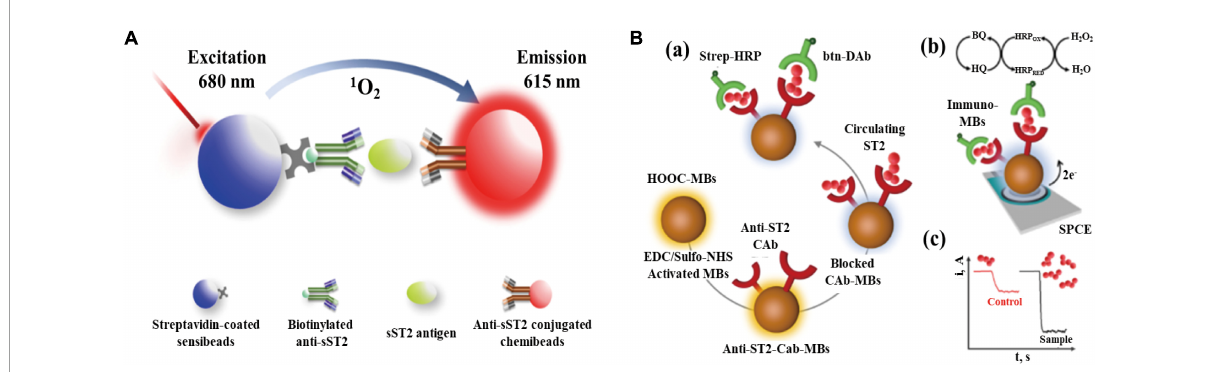
FIGURE3 (A) Schematic representation of AlphaLISA for measuring soluble growth stimulation expressed gene 2 (sST2) through double-antibody sandwich immunocomplexes; (B) Preparation of the MB-based immunosensor for measuring sST2. (a) Steps in the sandwich immunoassay. (b) Electrochemical transducer and reactions involved in the amperometric readout. (c) Example of amperometric traces recorded for control and high ST2 samples (Have obtained the appropriate permissions form DMP and MDPI).